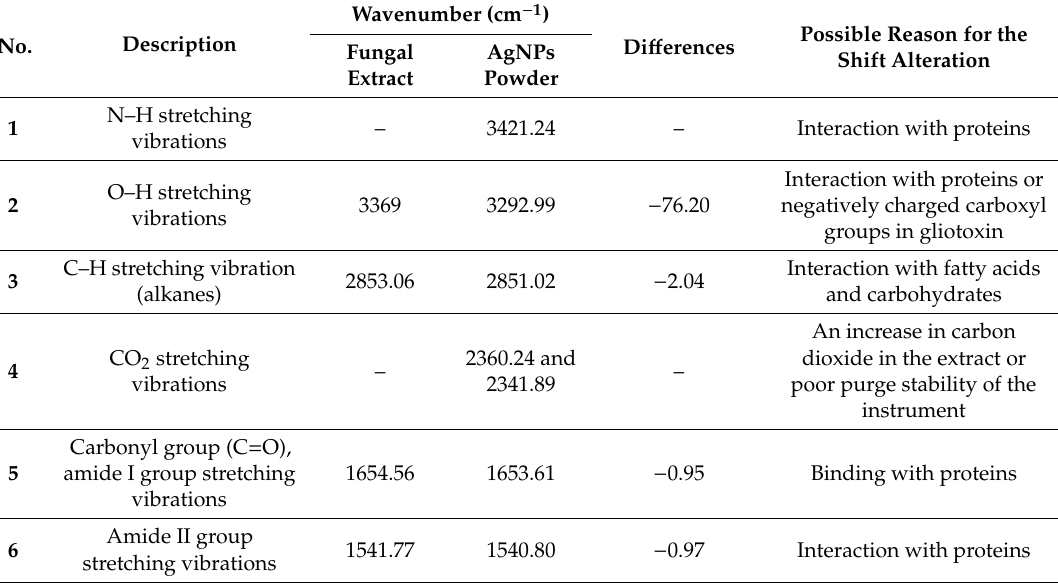
Figure 3. FT ‐ IR spectra of three samples: ( a ) Gliotoxin; ( b ) T. virens extract; ( c ) AgNPs. Table 1. Fourier-transform infrared spectral characteristics of fungal extract and AgNPs